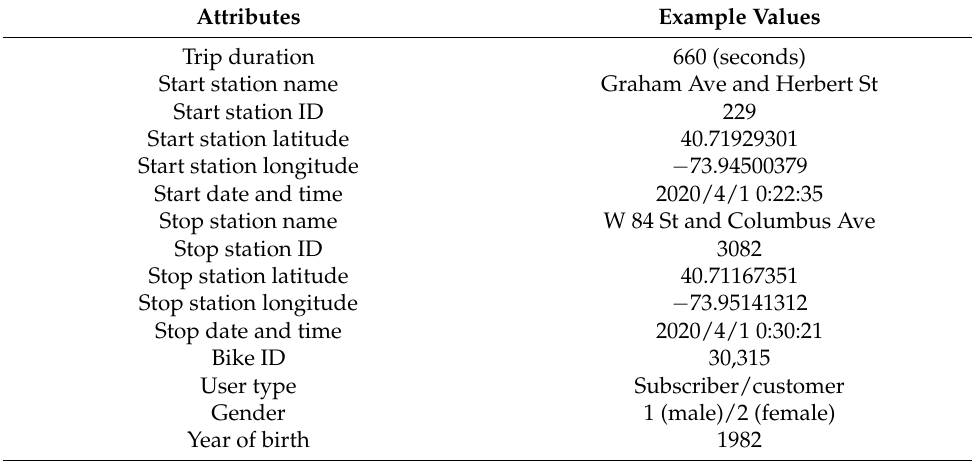
Table 1. Attributes and example values of trip